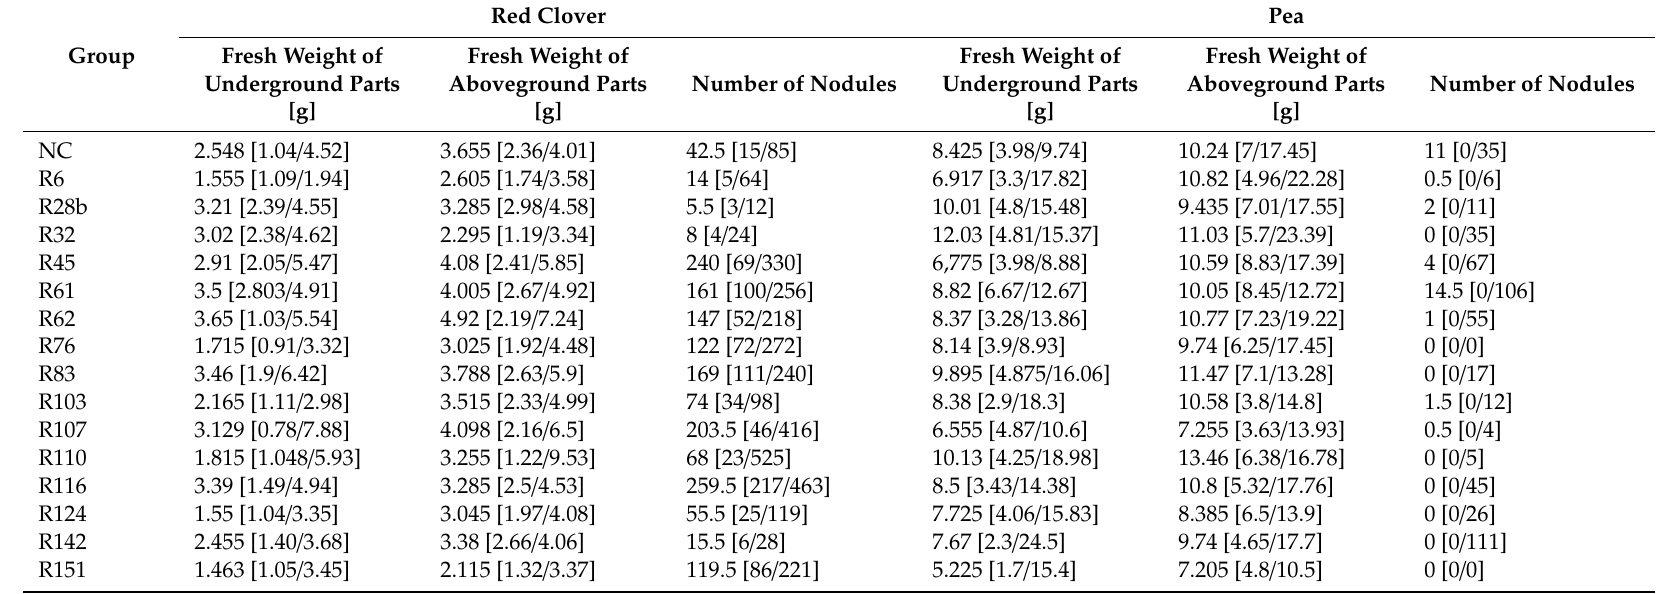
Table 2. Fresh weight of underground and aboveground parts, number of nodules in Red clover and Pea., results are shown as median and 95%CI, n = 10.